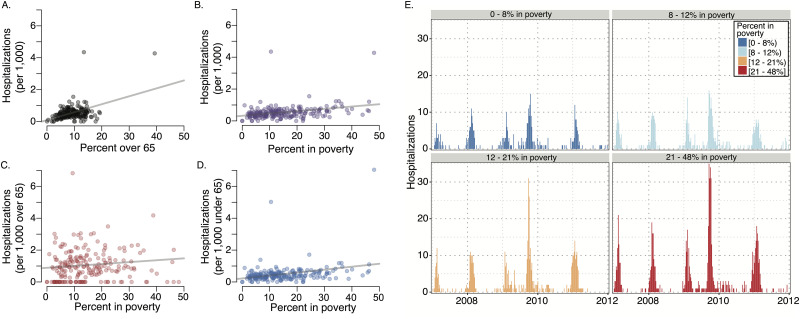
Relationship between age, poverty level, and influenza hospitalizations across 305 ZIP Codes from 2007 to 2012.Demographic data are based on 2010 Census. (A) Influenza hospitalizations increase with the size of the over 65 population (p <.001). (B) Influenza hospitalizations increase with the percent of the population under the federal poverty level (p <.001). (C) Influenza hospitalizations in over 65 year olds does not significantly increase with poverty (p = .11). (D) Influenza hospitalizations in under 65 year olds does significantly increase with poverty (p <.001). (E) The weekly number of hospitalizations across each of the four poverty quartiles. Because the quartiles were selected to include comparable population sizes, we find 2—3 times higher rates of inpatient hospitalizations in the most impoverished quartile (red) as compared to the least (dark blue).